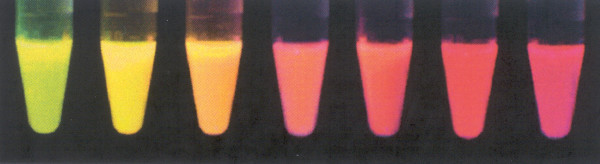
Fluorescence of DsRed variants developed by Shaner et al [6] (from left to right, mHoneydew, mBanana, mOrange, tdTomato, mTangerine, mStrawberry, mCherry; reproduced with the permission of [6]; refer to the same reference for details).